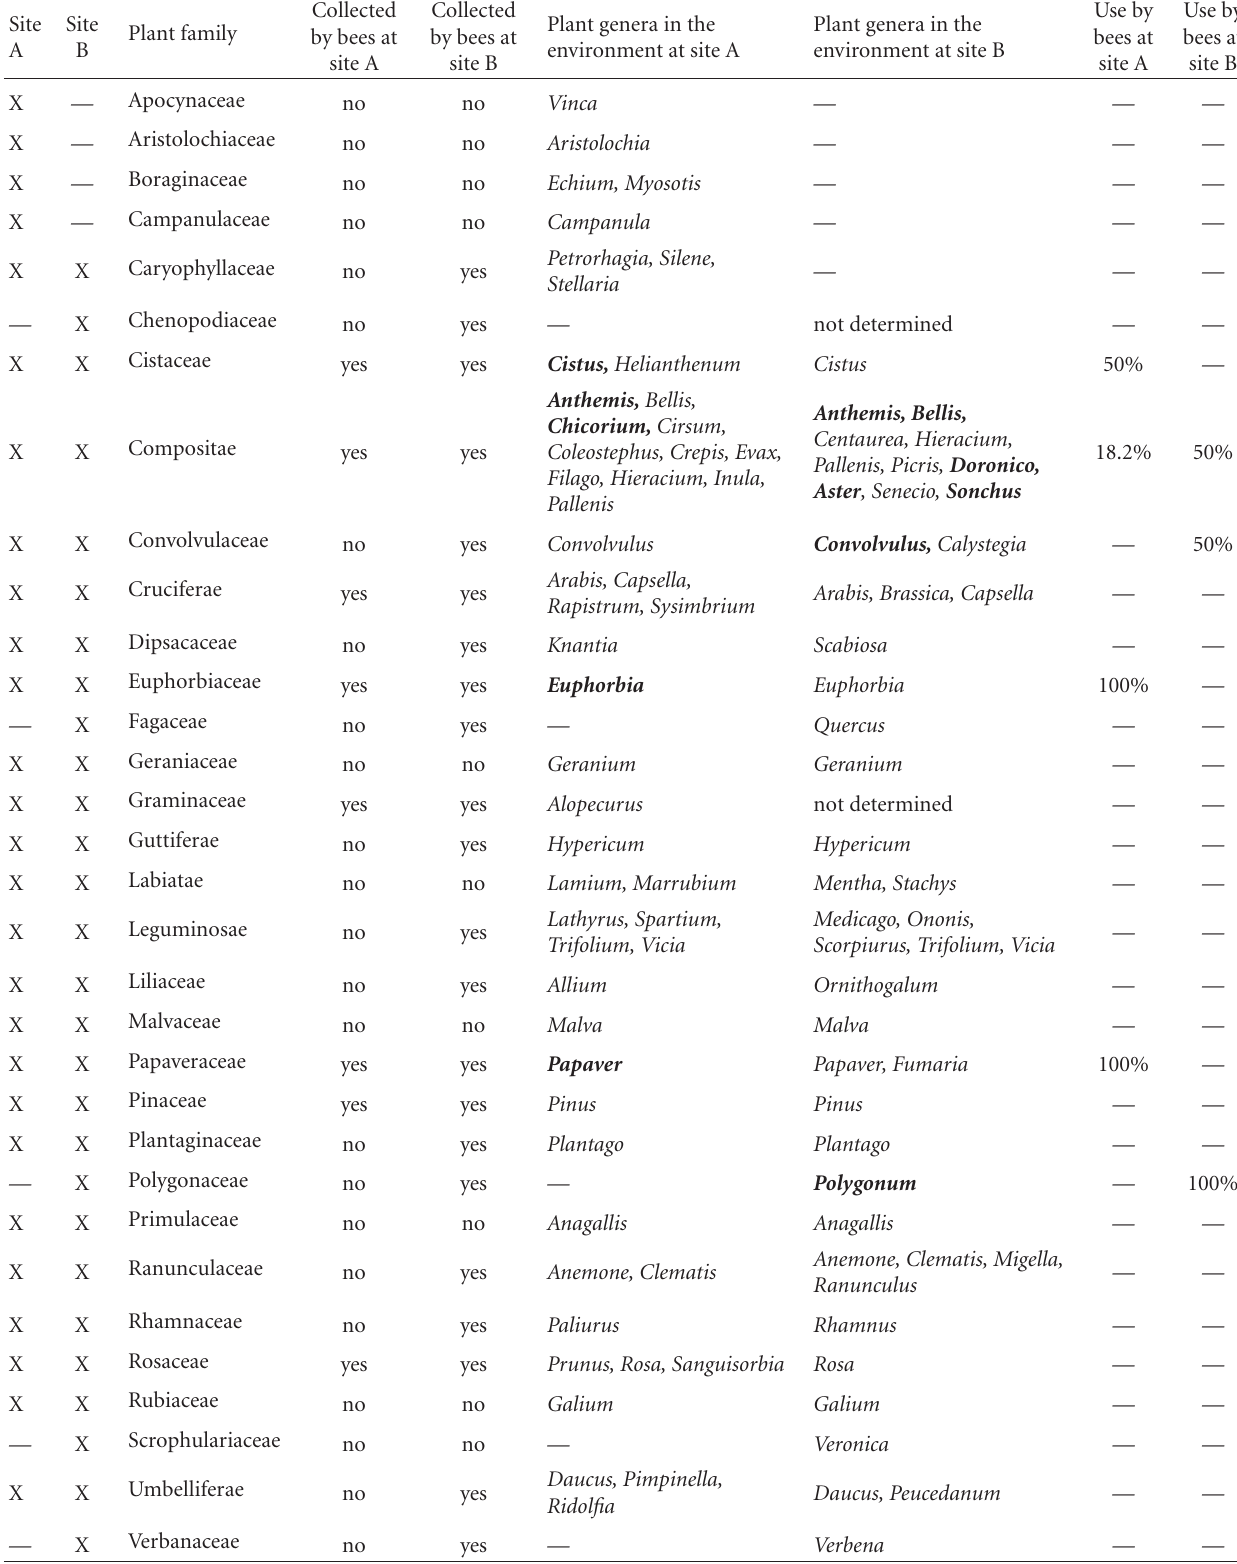
Table 1: List of families and genera collected in the environment around L. malachurum nesting sites, and relative use of plant genera/pollen types (richness of used taxon/richness in the environment ∗ 100) in the families where genera/type-level identification of pollen from bees was possible. Genera/types in bold were found in bee pollen loads. Only taxa represented in pollen loads by more than 1% were